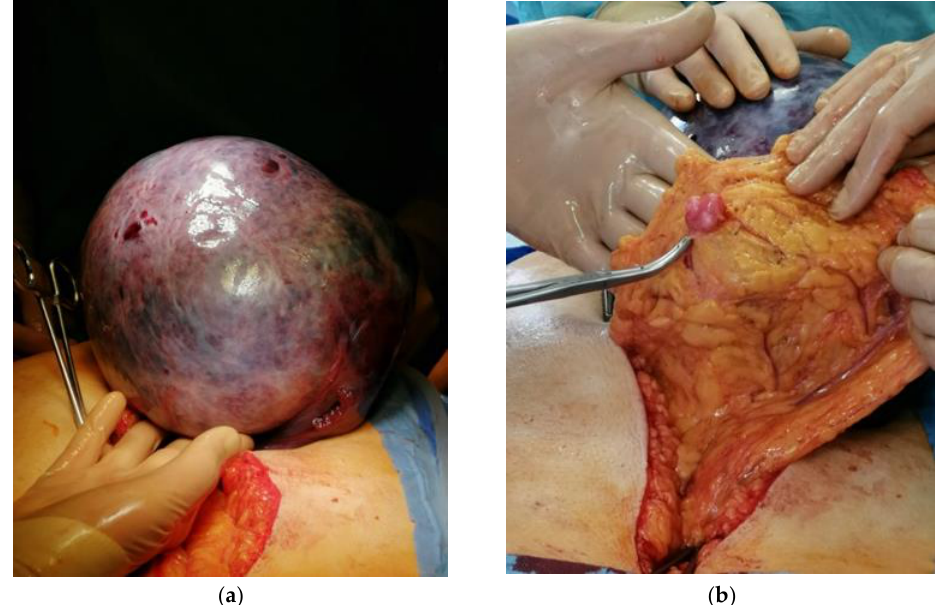
Figure 2. Pictures taken during surgery: ( a ). Right ovary tumor pulled out of the abdominal cavity. ( b ). Parasitic fibroma located on the omentum.